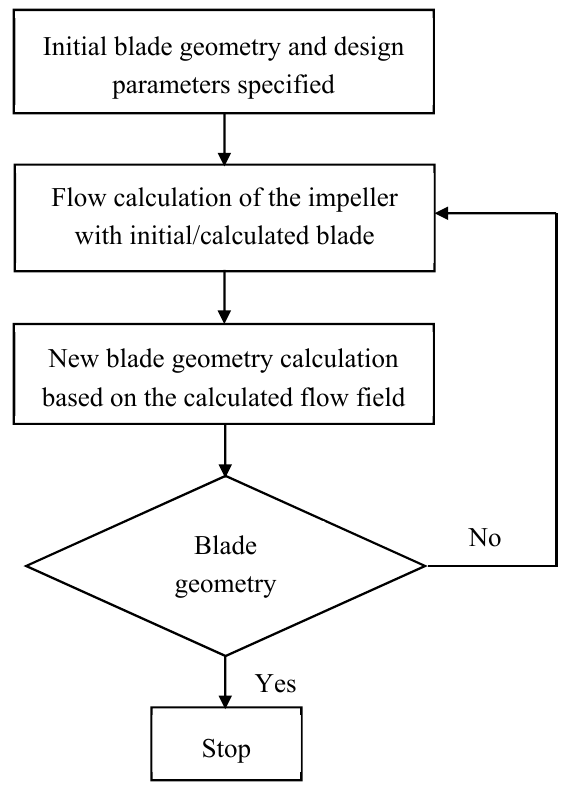
Figure 1. Flow chart for the basic calculation process of the inverse design method.